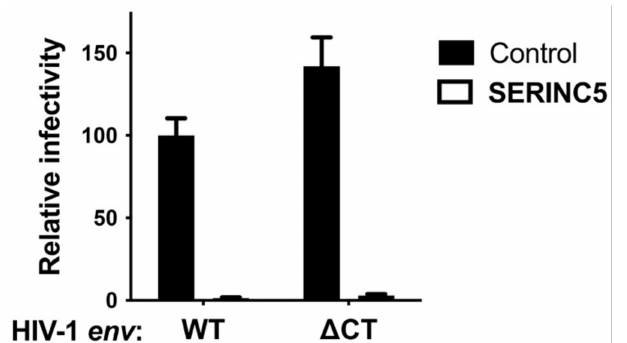
Figure 2. HIV-1 Env with a deletion in the cytoplasmic tail is sensitive to SERINC5 restriction activity. HIV-1 pseudotypes bearing HIV-1 Env, either WT or with deletion of amino acids after 710, were produced by co-transfection of HEK293 cells with a SERINC5 expression plasmid or control. Target cells were TZMbl cells. Each condition shows results of vector production from at least three independent transfections. Statistical significance of the observed SERINC5 effects was determined as in Figure 1, and in each case p <